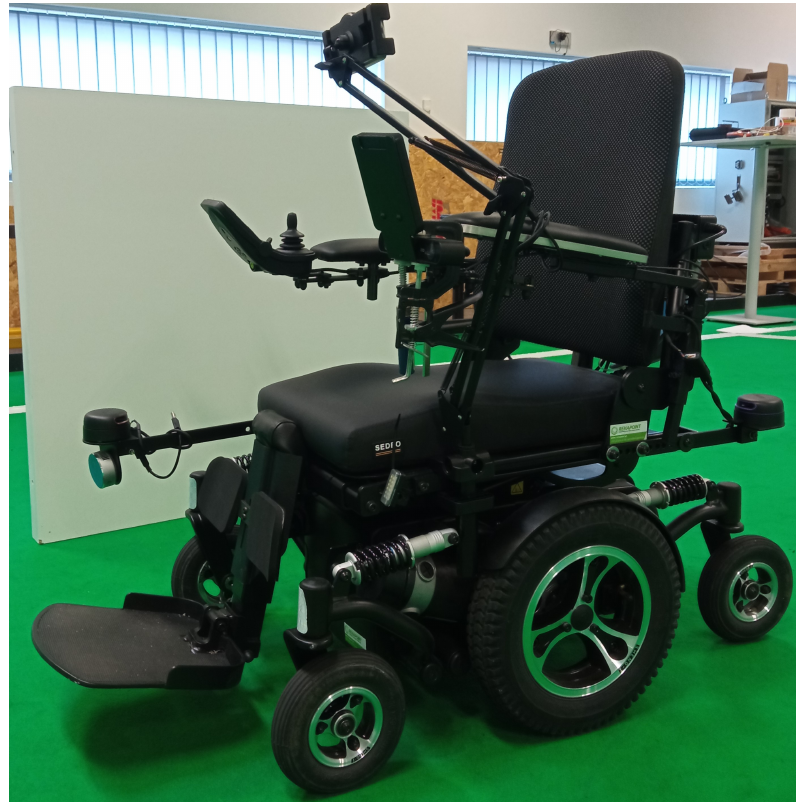
Figure 6. TA IQ MWD wheelchair with the smartphone